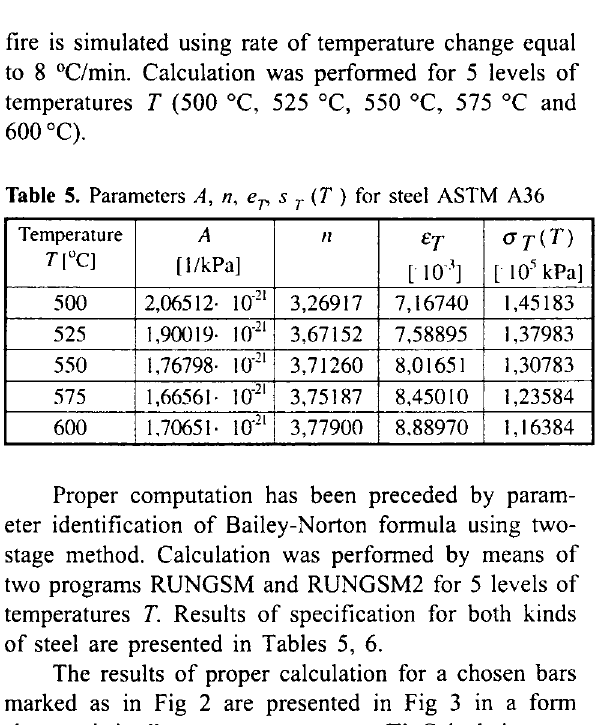
Table 5. Parameters A, n, eT' s r (T ) for steel ASTM A36